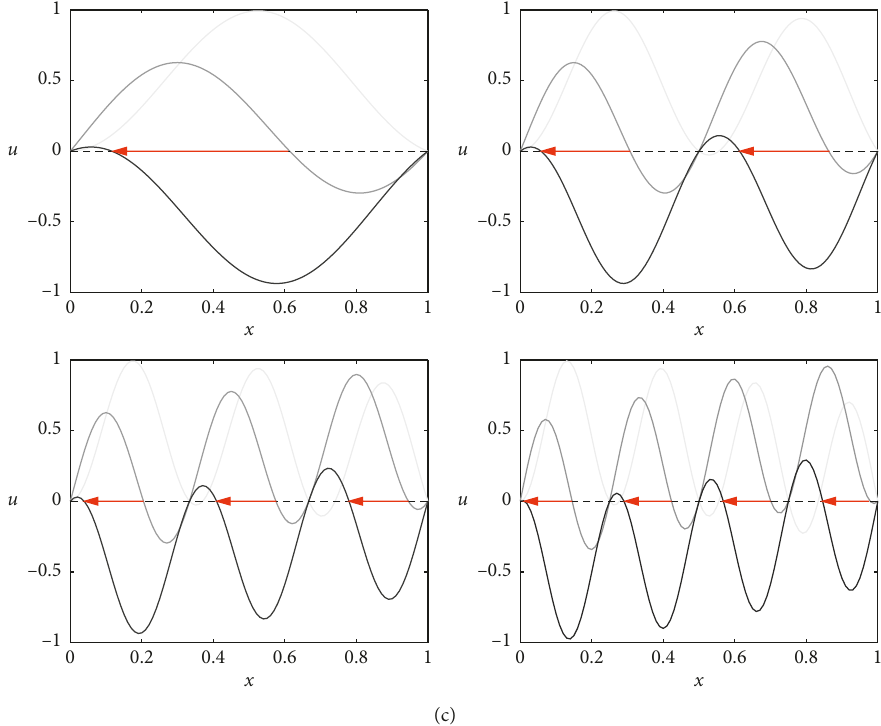
Figure 2: First four-order modes of an axially moving string. Every single curve plotted by the colored levels from shallow to deep denotes the modal motion in different time. The red arrows denote the wave direction. (a) v � 0.1, (b) v � 0.5, and (c) v �